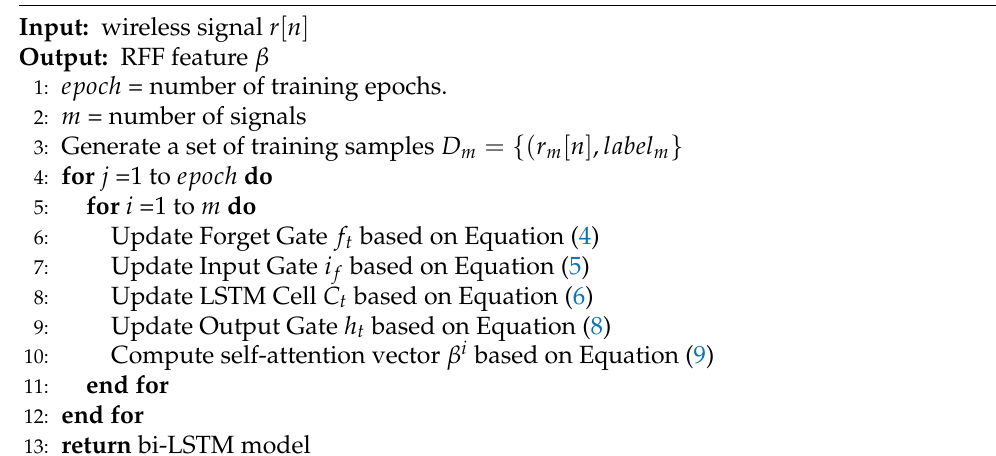
Algorithm 1 RFF Extraction Algorithm Based on